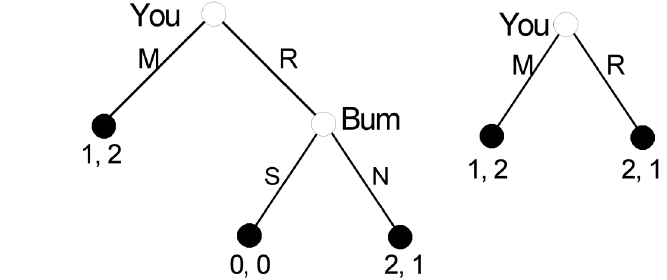
Figure 2. The game of Bum (left panel) and Bum reduced after applying the first step of backward induction (right